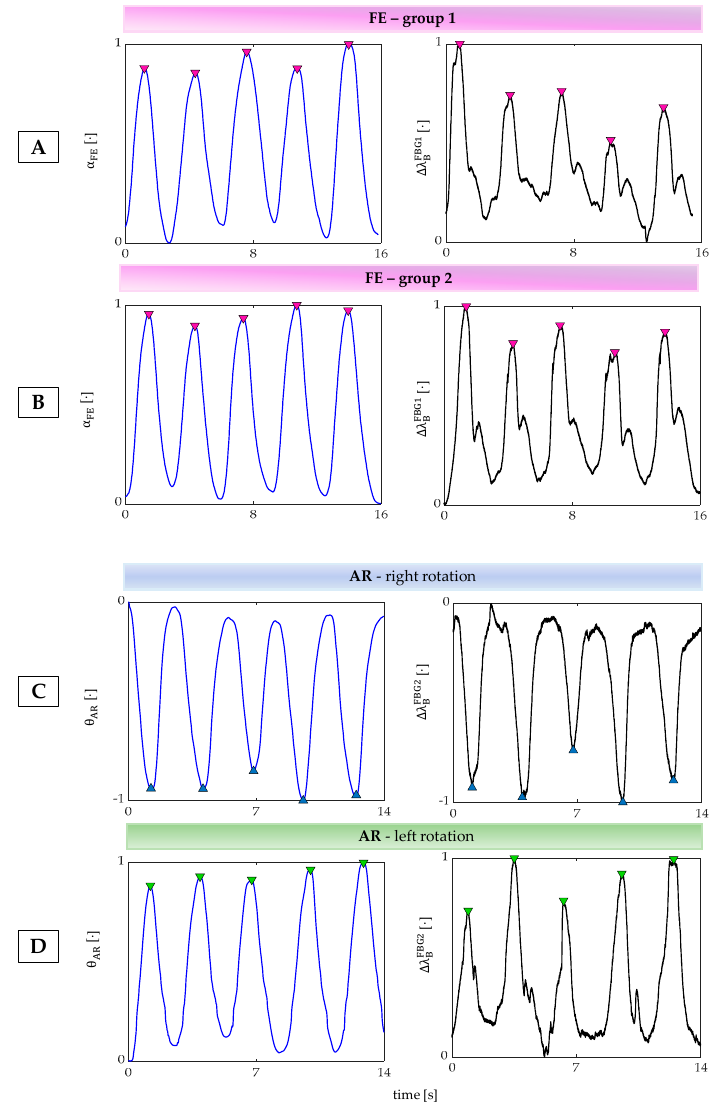
Figure 5. ( A ) The peak detection during the first group 5 FE, ( B ) the second group 5 FE right, ( C ) right AR repetitions, ( D ) left AR repetitions.